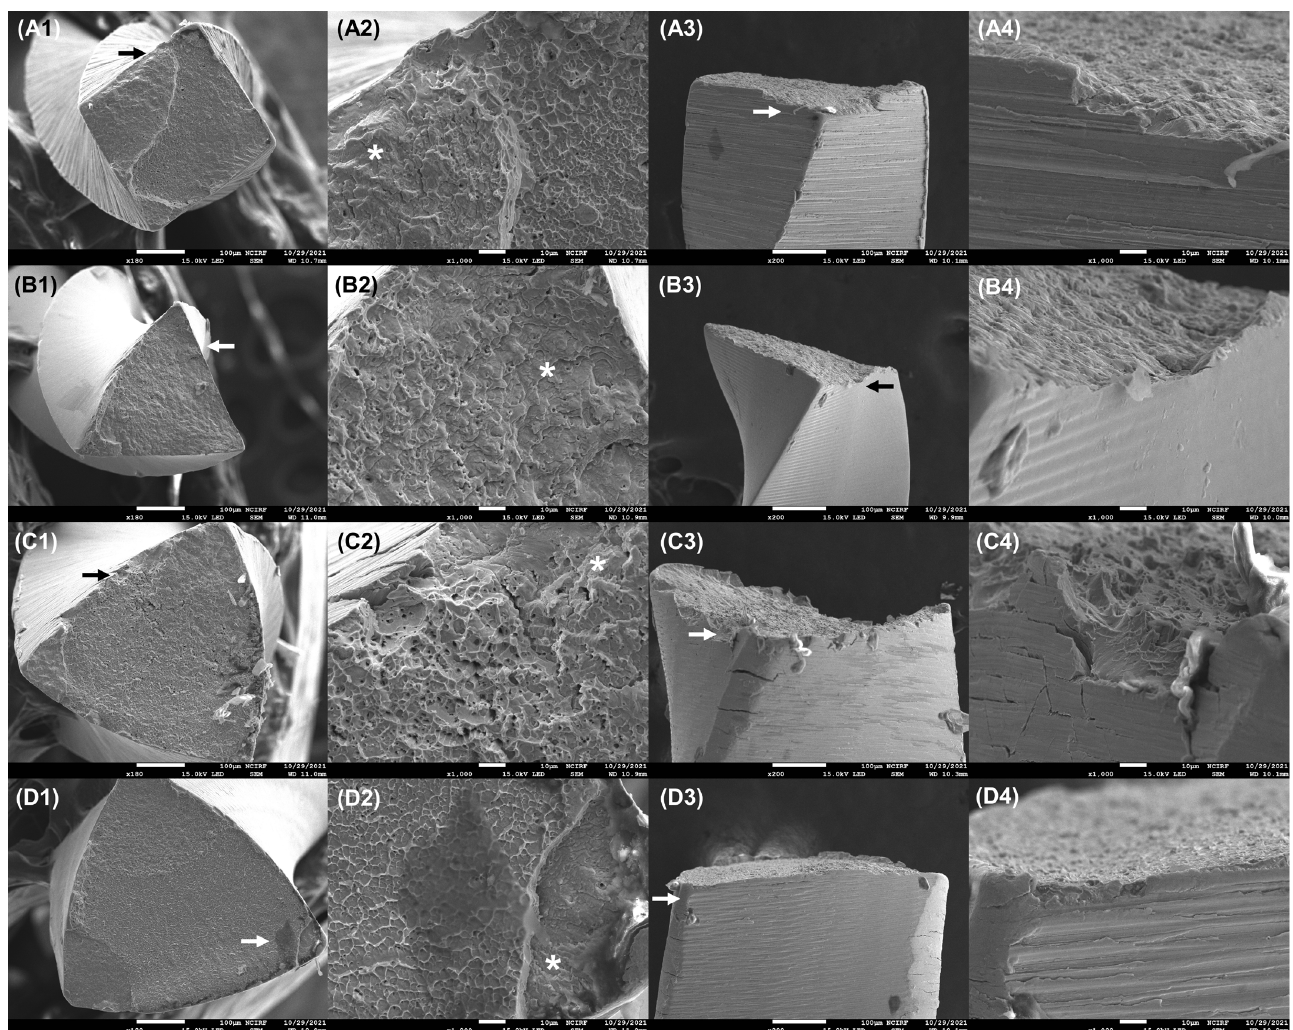
Figure 3. Scanning electron microscopic photographs of TruNatomy Prime ( A1 – A4 ), XP-endo Shaper ( B1 – B4 ), Spring Endo ( C1 – C4 ), and Spring H ( D1 – D4 ) files after the cyclic fatigue resistance test. ( A1 , B1 , C1 , D1 ) ( × 180) fractured surface; ( A2 , B2 , C2 , D2 ) ( × 1000) magnified view of sections indicated by arrows in A1 , B1 , C1 , and D1 , respectively; ( A3 , B3 , C3 , D3 ) ( × 200) lateral surface; ( A4 , B4 , C4 , D4 ) ( × 1000) magnified view of sections indicated by arrows in A3 , B3 , C3 , and D3 , respectively. The asterisk indicates fatigue